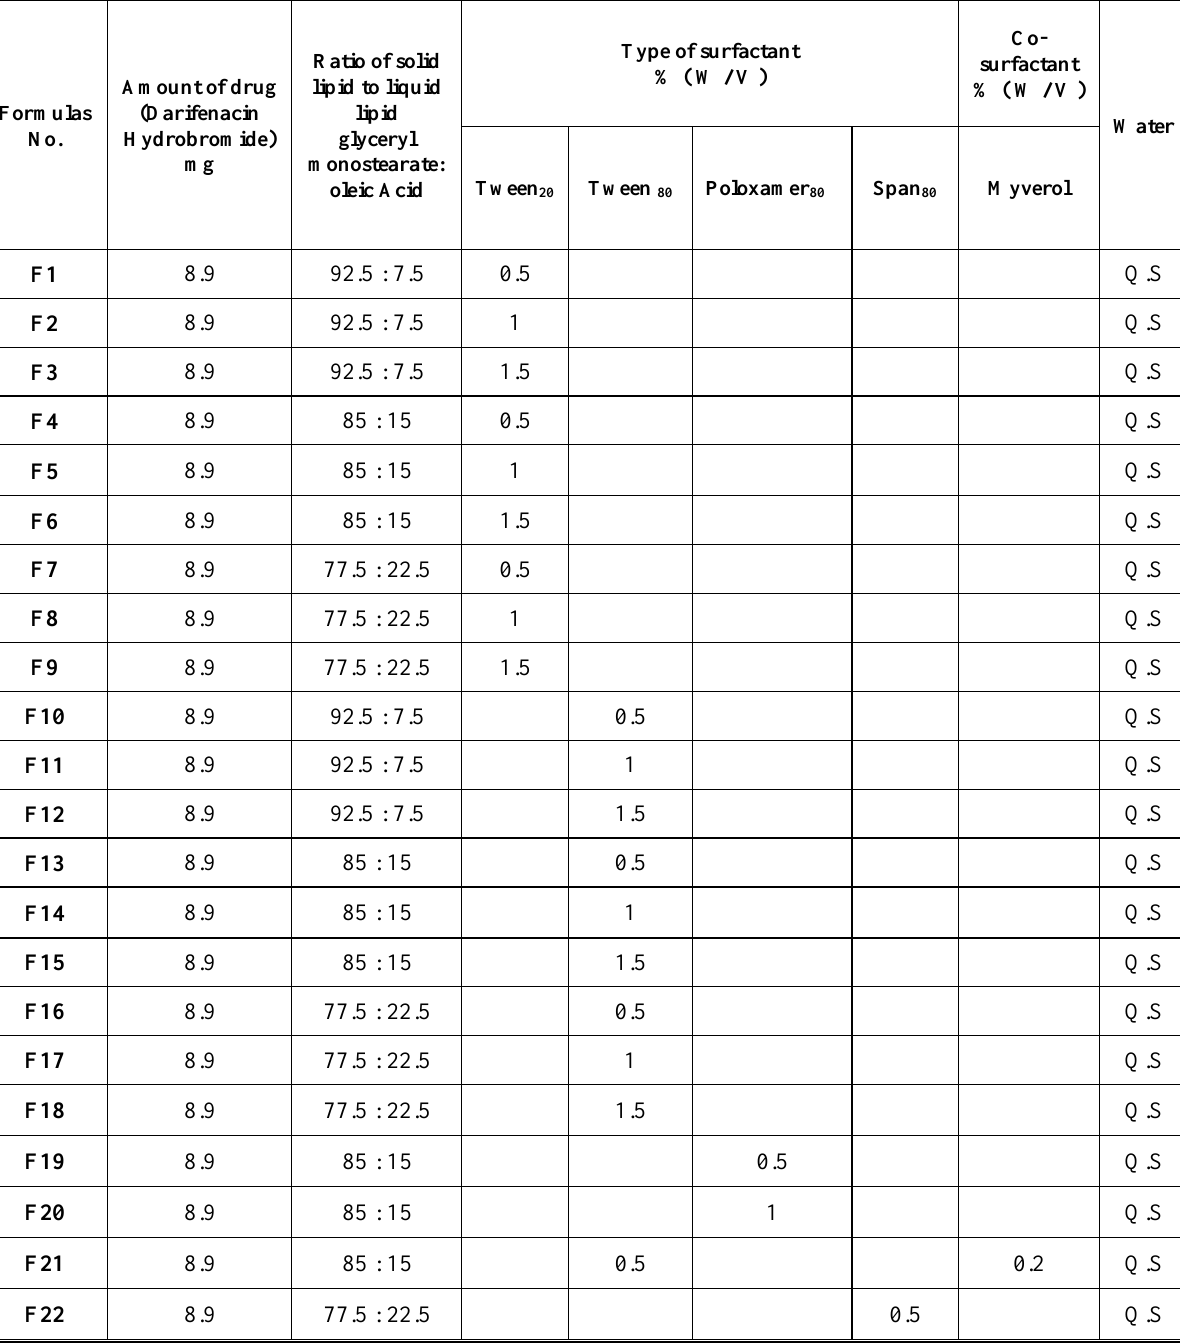
Table1. Formulations of darifenacin hydrobromide loaded nanostructured lipid carriers ( NLCs)